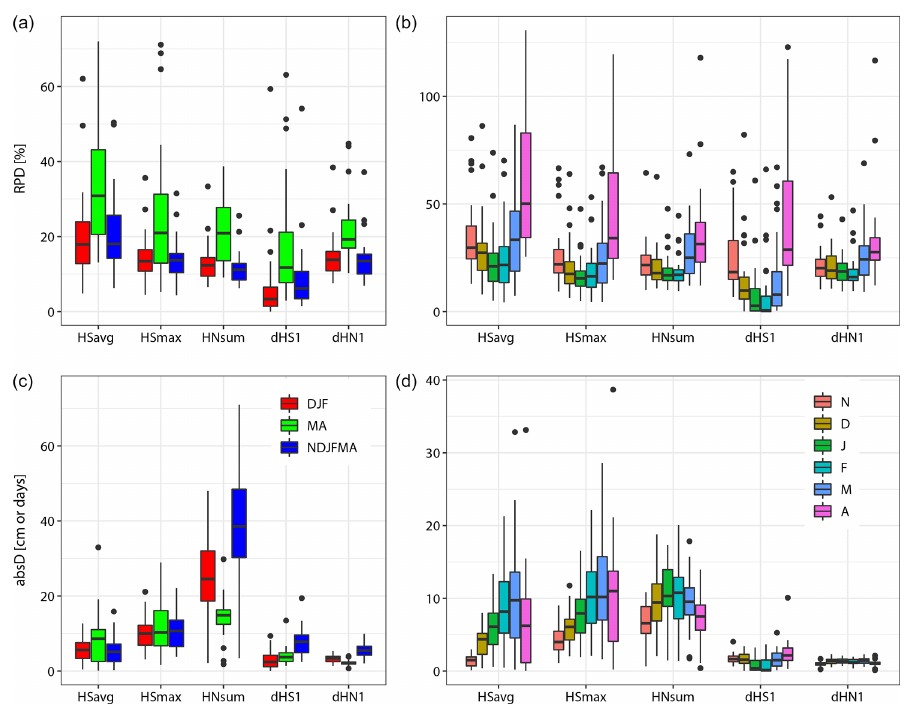
Figure 2. Shown are relative percentage deviations (RPD) and absolute differences (absD) for five snow climate indicators. Depicted are (a, b) three seasons from December to February (DJF, red), March–April (MA, green), and November to April (NDJFMA, blue) and (c, d) all months individually. Snow depth (HS) and snowfall (HN) indicators are based on 30 and 24 station pairs, respectively. The variables are defined in Table 1.